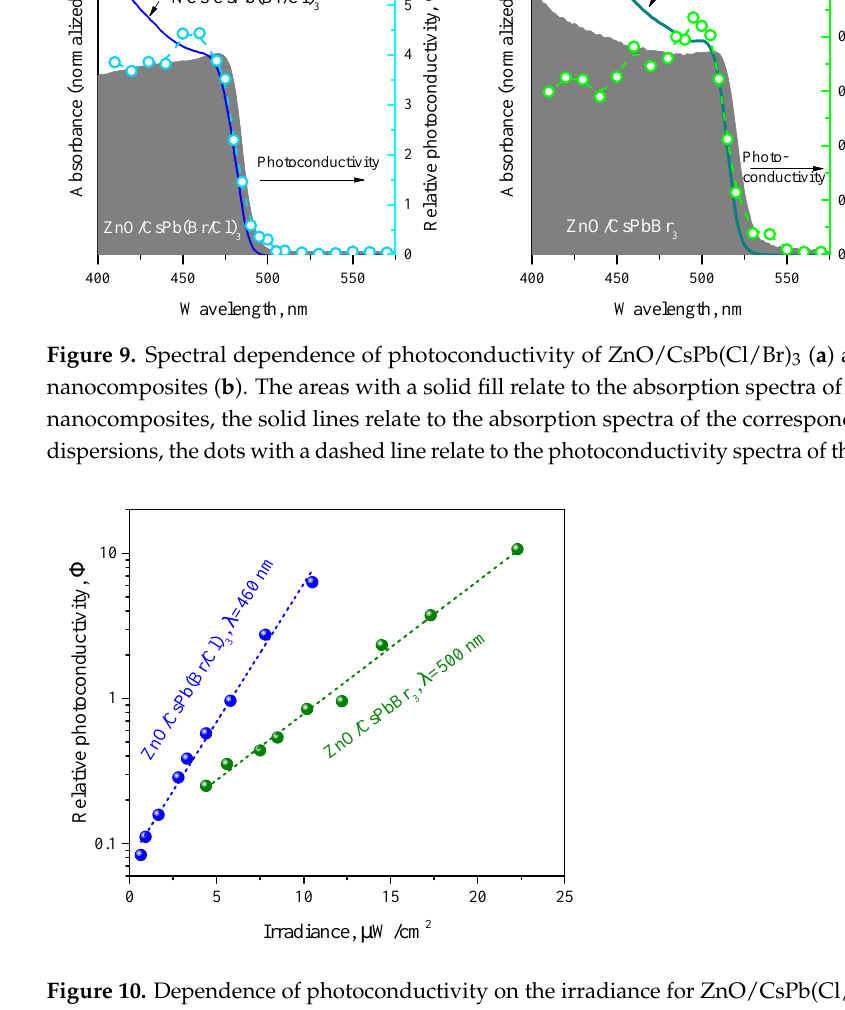
Figure 10. Dependence of photoconductivity on the irradiance for ZnO/CsPb(Cl/Br) 3 nanocompos- ite at 460 nm and for ZnO/CsPbBr 3 nanocomposite at 500